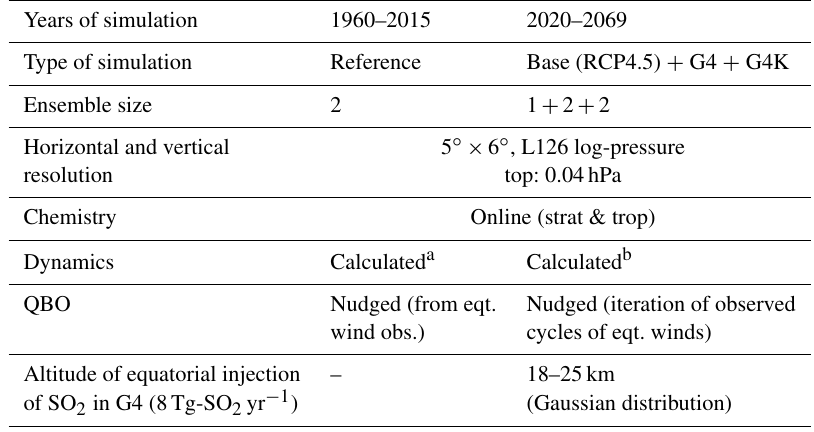
Table 1. Summary of ULAQ-CCM features and numerical experiments for the present